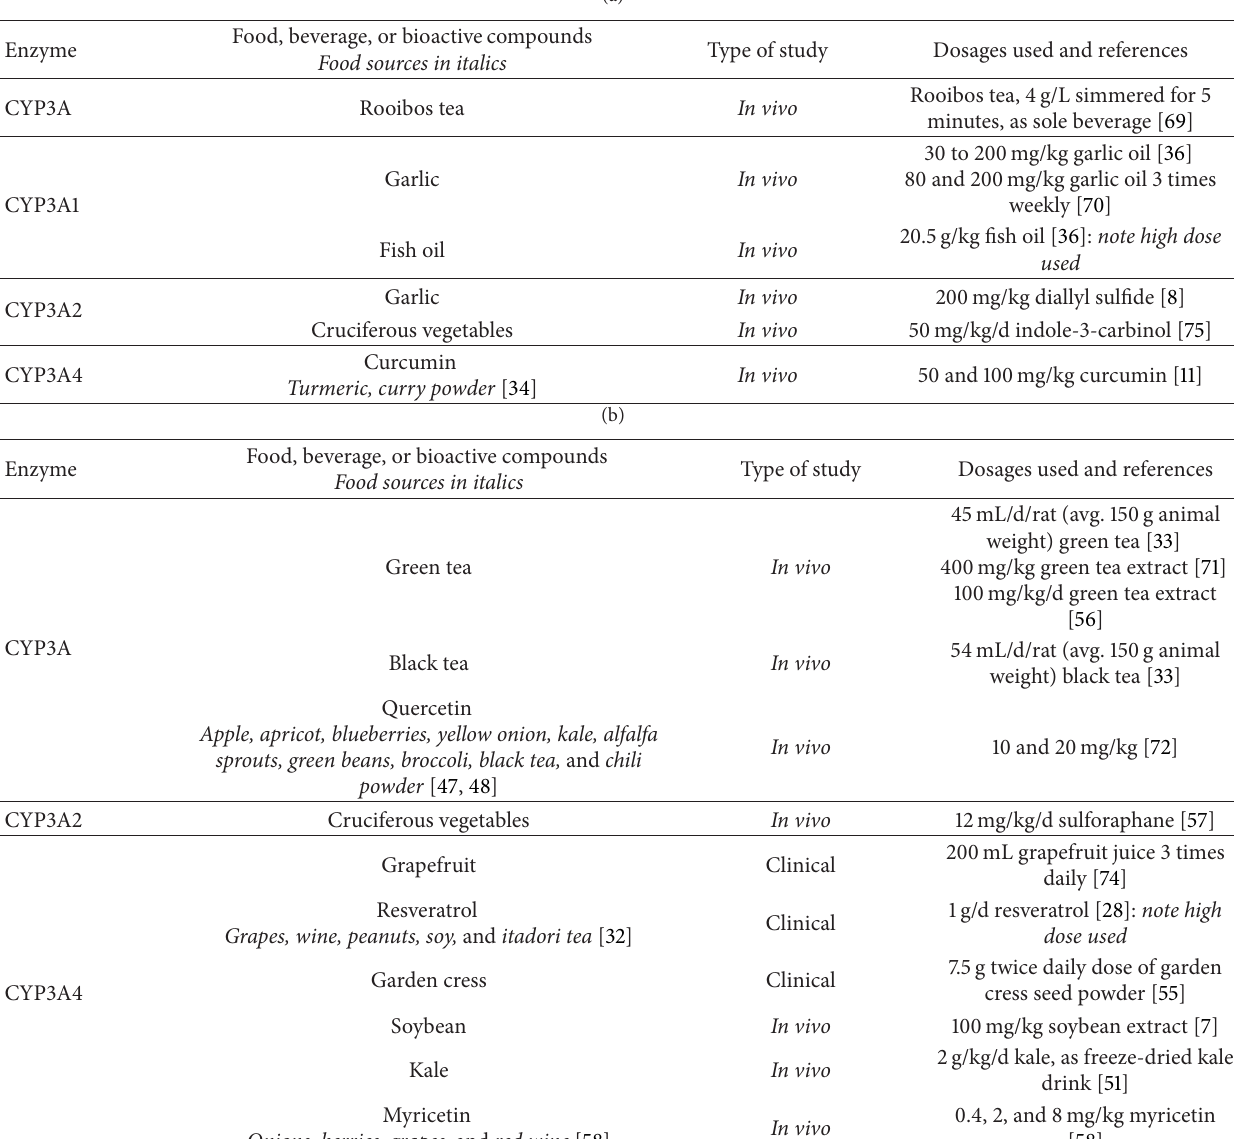
Table 3: (a) Human and in vivo example nutrient inducers of selected CYP3 enzymes. (b) Human and in vivo example nutrient inhibitors of selected CYP3 enzymes.